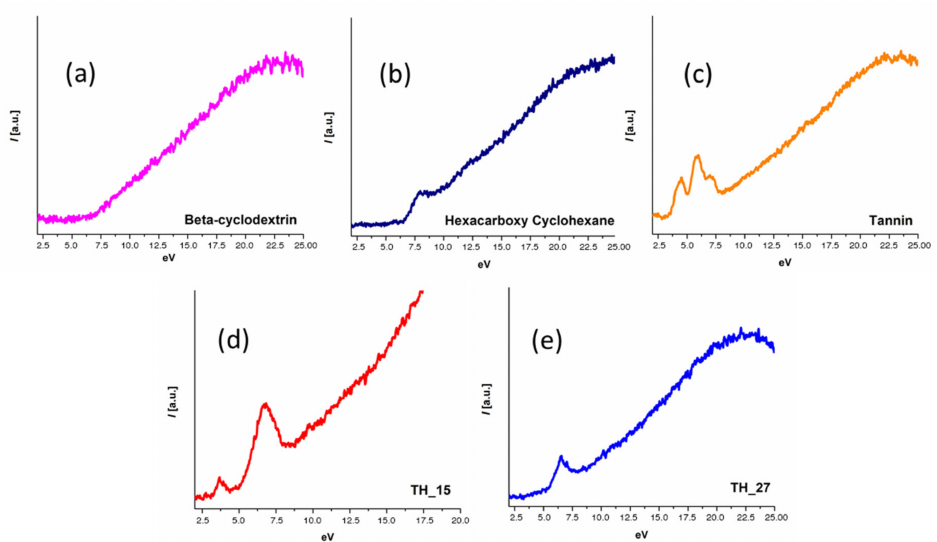
Figure 2. Low loss electron energy loss spectroscopy (EELS) for various organic small molecules showing characteristic ( π – π * transition peaks) in low loss region, for ( a ) beta-cyclodextrin with no characteristic signal; ( b ) hexacarboxy cyclohexane ~8 eV; ( c ) tannin ~4.5, ~4.9, ~7.2 eV; ( d ) peptide TH_15~3.8, ~6.9 eV, ( e ) peptide TH_27~6.5 eV peak was observed.